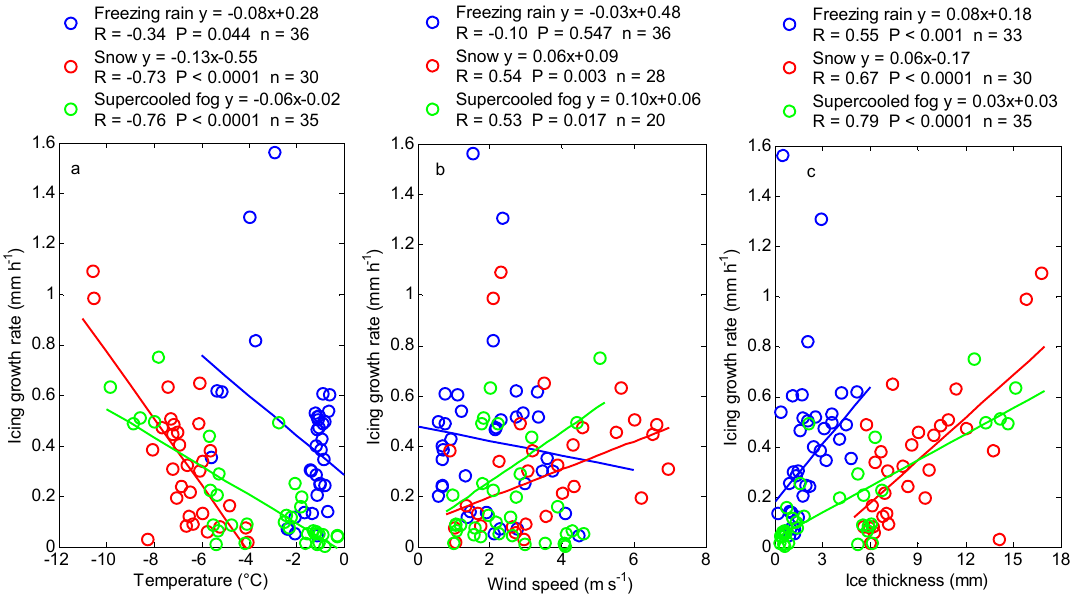
Figure 6. Correlations between icing growth rate and ( a ) air temperature, ( b ) wind speed, and ( c ) ice thickness under freezing rain (blue), snow (red), and supercooled fog (green). R represents Pearson correlation coefficient, P represents P-value of t-test, and n represents the sample size.